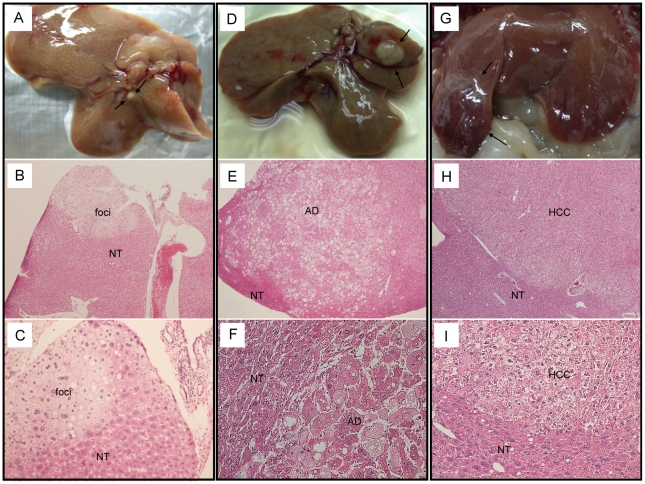
RBMY induced hepatic neoplastic changes in transgenic mice.(A–C) Pre-neoplastic lesion in a 15-month-old male mouse RF1-278. (D–F) Adenoma (AD) in a 24-month-old female mouse RF4-21. (G–I) HCC in a 21-month-old male mouse RF2-390. Magnification: B, E, H, ×50; C, F, I, ×200.